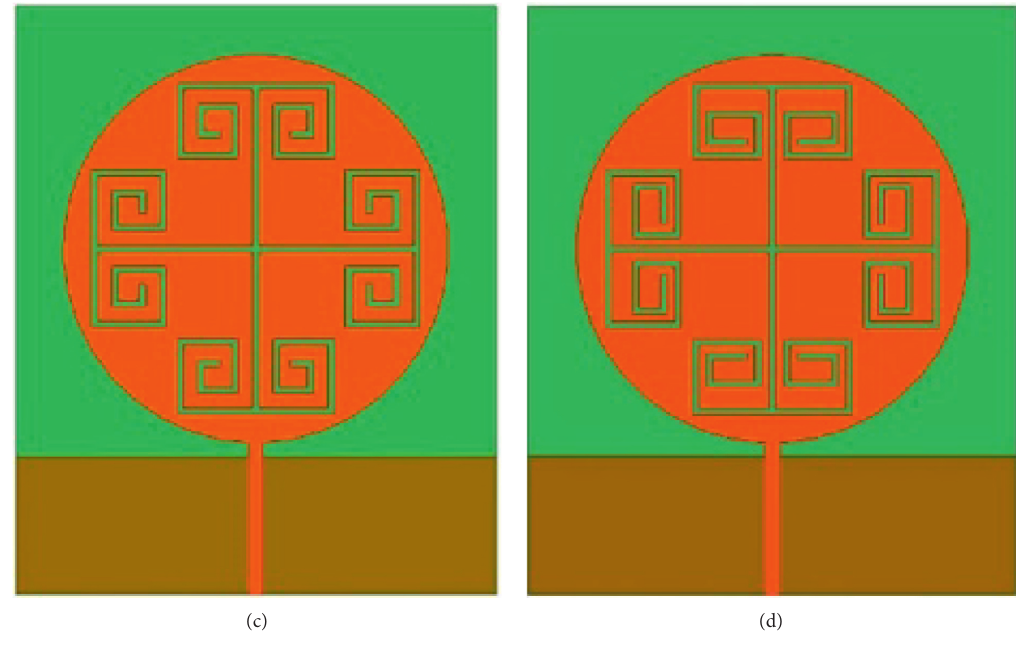
Figure 4: Antenna evolution process structure diagram. Table 3: Changes in the frequency band when antennas are derived.